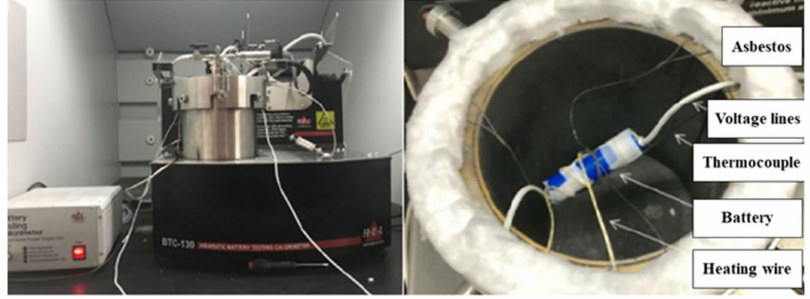
Figure 1. Experimental platform for thermal runaway